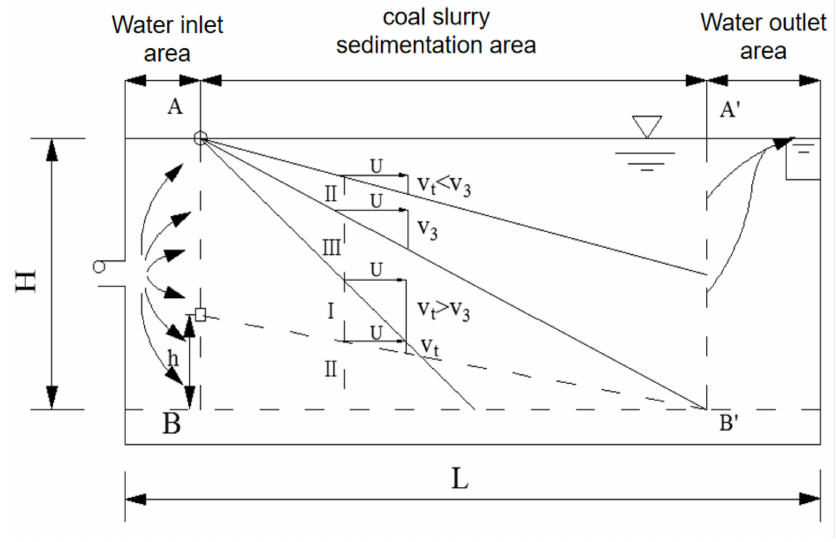
Figure 9. Schematic diagram of the ideal settling pond (vertical cross-section of the settling